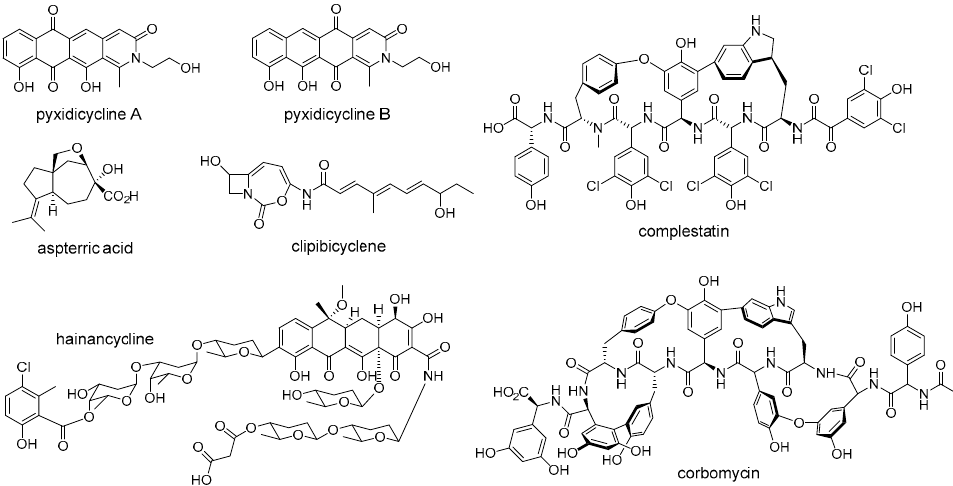
Figure 5. Structures of representative natural products that discovered by using antibiotic resistance gene as a